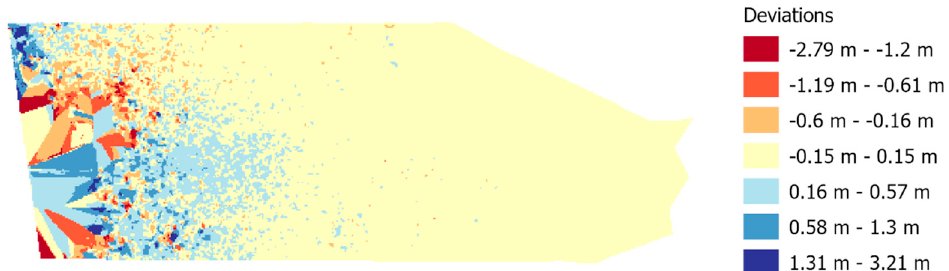
Figure 10. Deviation of depth values between photogrammetric surface and BRS.